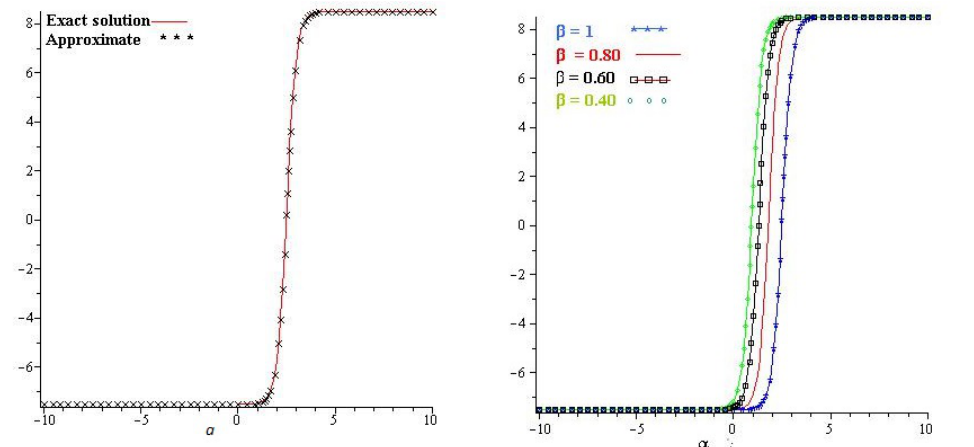
Figure 3. Exact and NDM solution of µ ( α , η ) at different fractional order δ = 1,0.8,0.6,0.4, and η = 1.